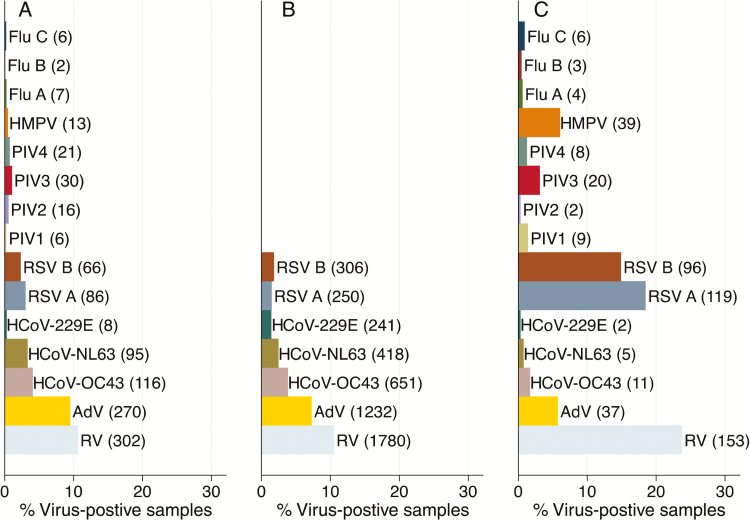
Frequency distribution of the detected respiratory viruses in NPS collections from the (A) six households with full respiratory screen and (B) the 47 households for the common targets screen and (C) inpatient samples collected over the same study period, December 2009–June 2010. Abbreviations: Adv, adenoviruses; Flu A, B, and C, influenza type A, B, and C; hCoV-OC43, hCoV-NL63 and hCoV-229E are strains of human coronaviruses; HMPV, human metapneumoviruses; NSP, nasopharyngeal swabs; PIV 1, 2, 3, and 4, parainfluenza type 1, 2, 3, and 4; RSV A and B, respiratory syncytial virus group A and B; RV, rhinoviruses.